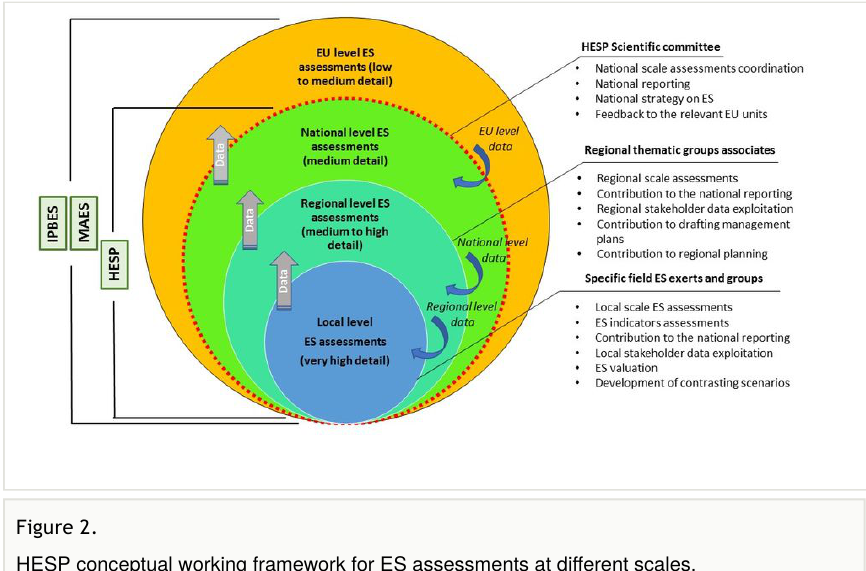
HESP conceptual working framework for ES assessments at di ff erent